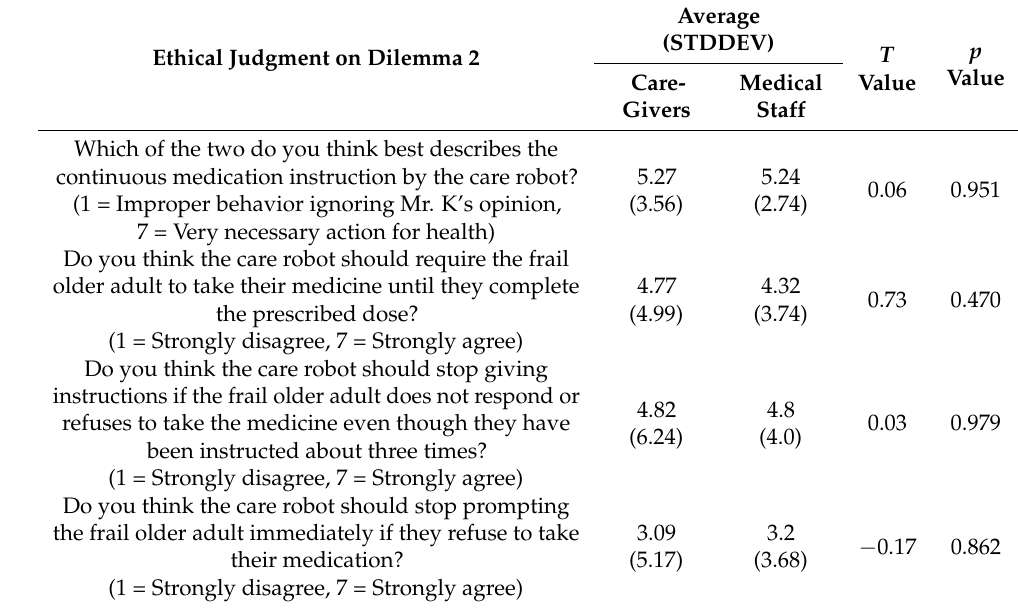
Table 3. Ethical judgment survey results of caregivers and medical staff on Dilemma 2.